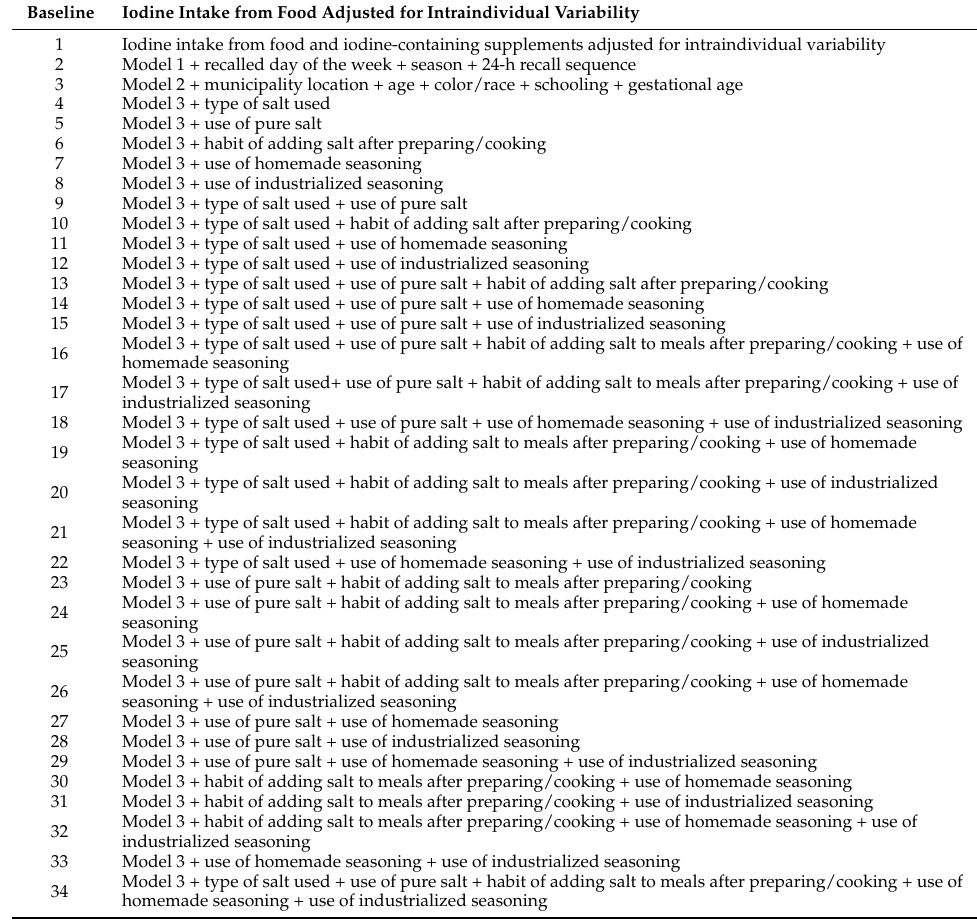
Table 1. Adjustment models to estimate the usual iodine intake of pregnant women and the preva- lence of inadequate intake, EMDI—Brazil, Brazil, 2023.